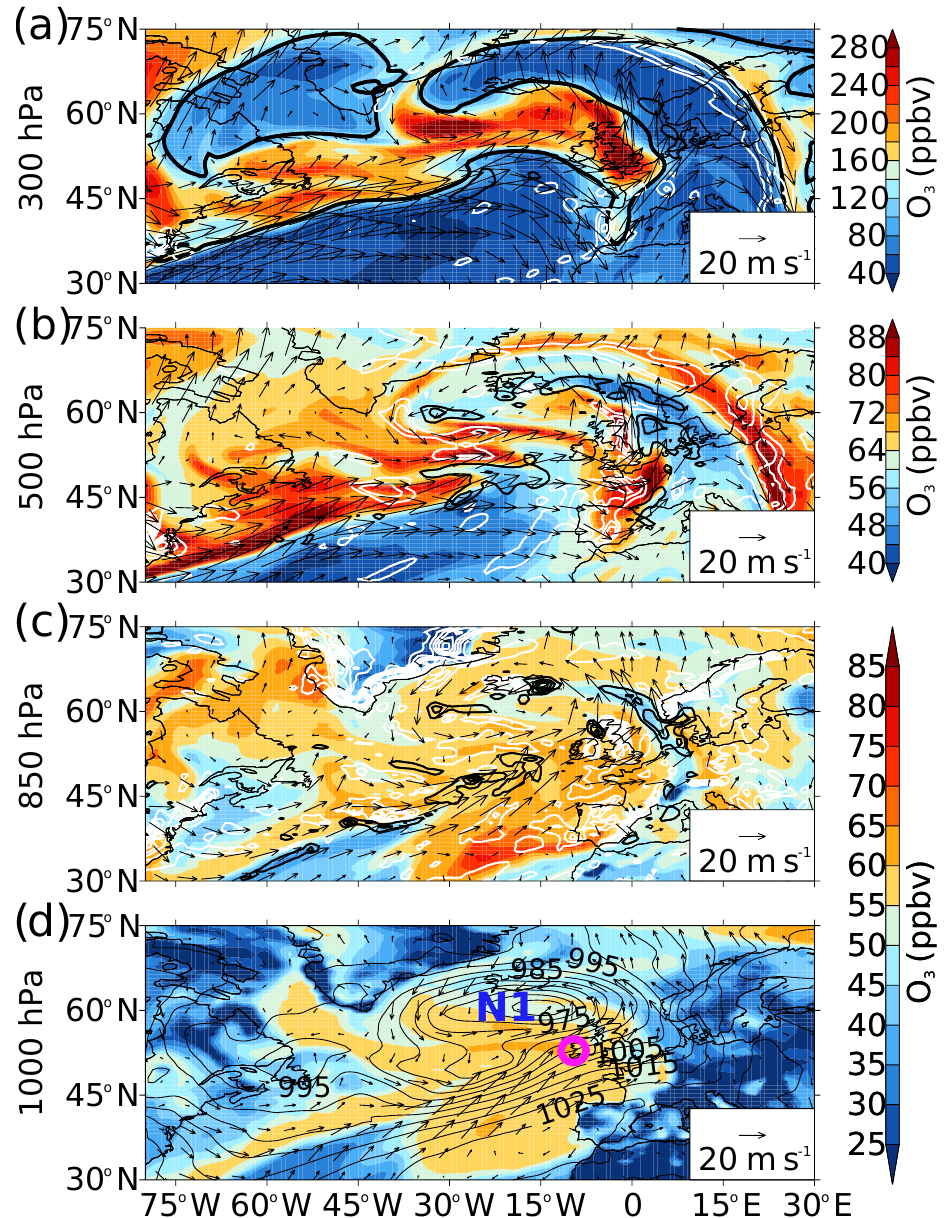
Figure 4. Synoptic conditions and O 3 distribution for the N1 cyclone (d ; 59 ◦ N, 13 ◦ W ) on 5 March 2007 at 00:00UTC, 24h after Fig. 3. High O 3 was reported at Mace Head. O 3 (color; note different scales used for different levels) and horizontal winds (20ms − 1 reference arrow) are shown on four levels: (a) 300hPa, (b) 500hPa, (c) 850hPa, and (d) 1000hPa. In addition, MSLP ( d ; solid contours, 5hPa intervals), ω ( a– c ; black contours for positive values indicating ascent, 15hPah − 1 contour intervals, and white contours for descent, − 5hPah − 1 contour intervals), and 2PVU isosurface ( a ; thick contour) are